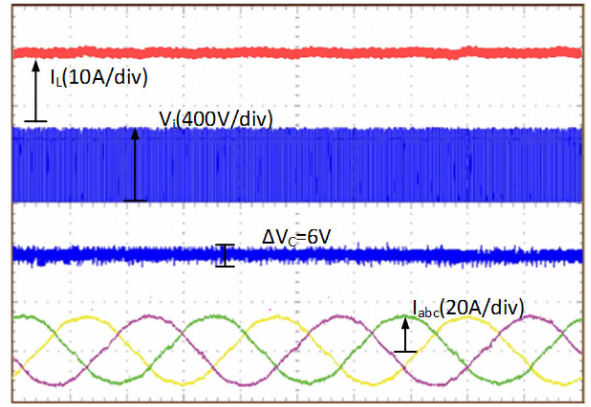
Figure 15. Experimental waveforms in the traditional PWM